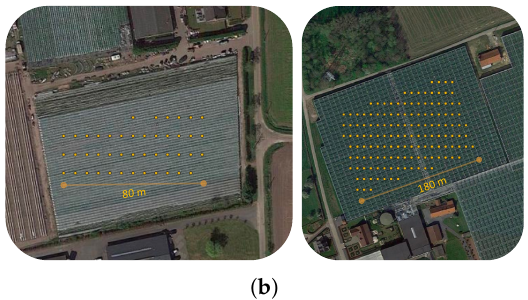
Figure 9. Anomalies of non-plastic greenhouse pixels (data acquisition is 20 April 2020—Rank 1). ( a ) Mean spectrum and standard deviation of greenhouse pixels compared uncovered bare soil. ( b ) Centroids of Sentinel-2 pixels (10 m by 10 m) of buffered parcels displayed on high resolution imagery.